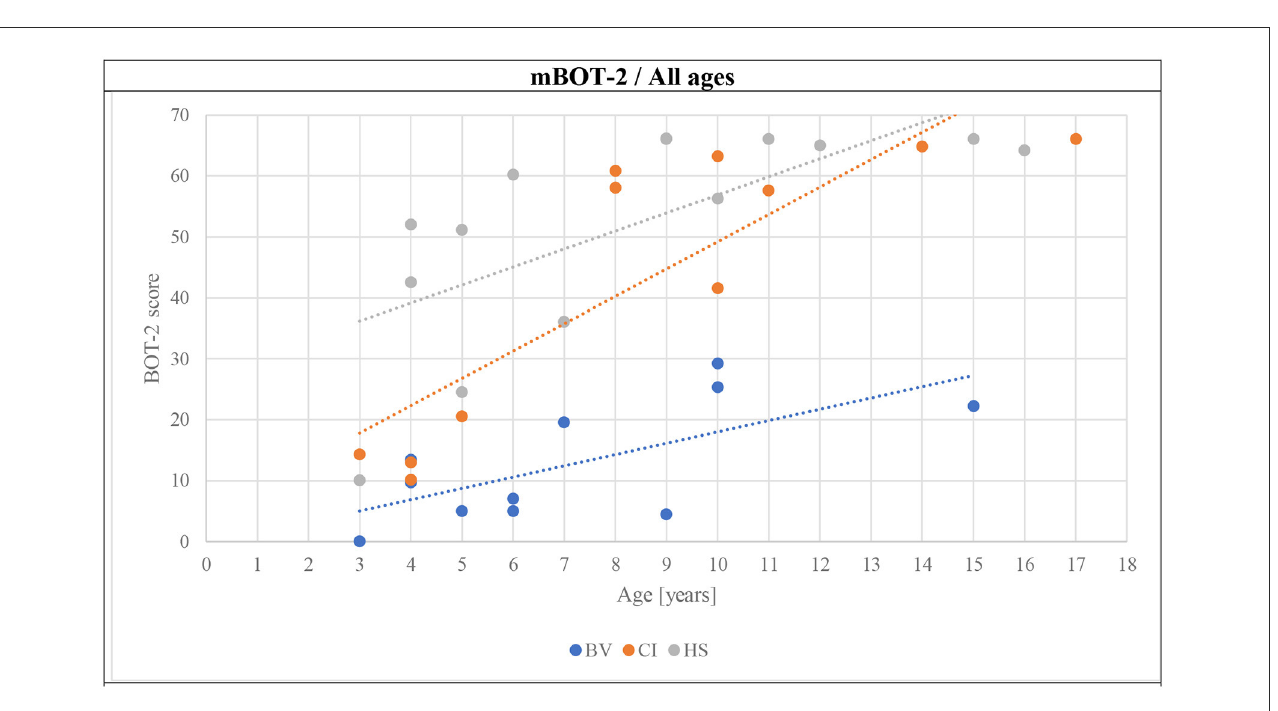
age, which would represent a useful tool that is currently lacking in the clinic for patients over a broad age range. Furthermore, the GBT is shorter to perform than BOT-2 or even the mBOT-2. The mBOT-2 showed saturation of the maximal scores by subjects